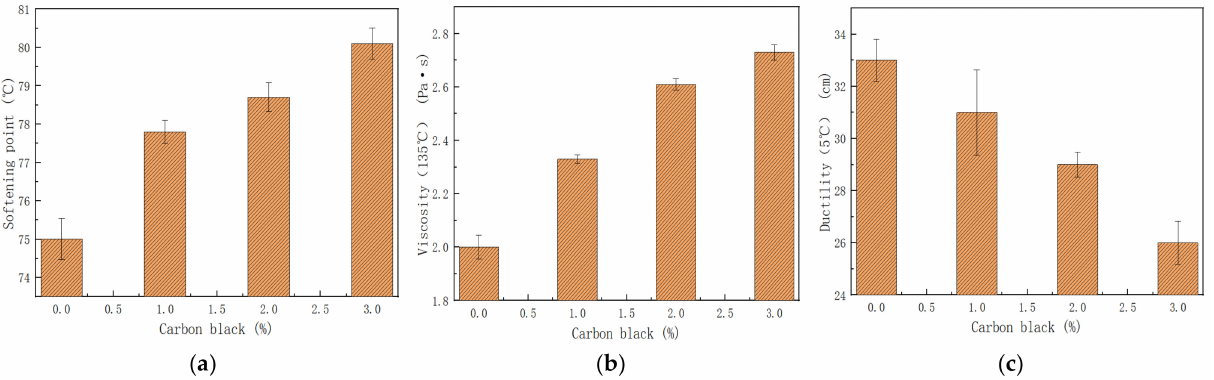
Figure 3. Effects of carbon black on the ( a ) softening point and ( b ) viscosity and ( c ) ductility of SBS-modified asphalt.